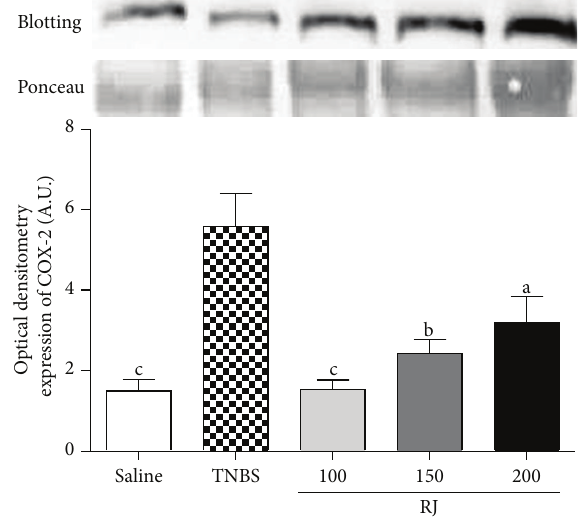
Figure 4: Representative Western blot analysis of COX-2 proteins. Densitometric data were studied following normalization to the control (Ponceau). The results are representative of three experi- ments performed on different samples and data are expressed as mean ± SEM. ANOVA followed by Dunnett’s 𝑡 -test. a 𝑃 < 0.05 , b 𝑃 < 0.01 , and c 𝑃 < 0.001 are significantly different from